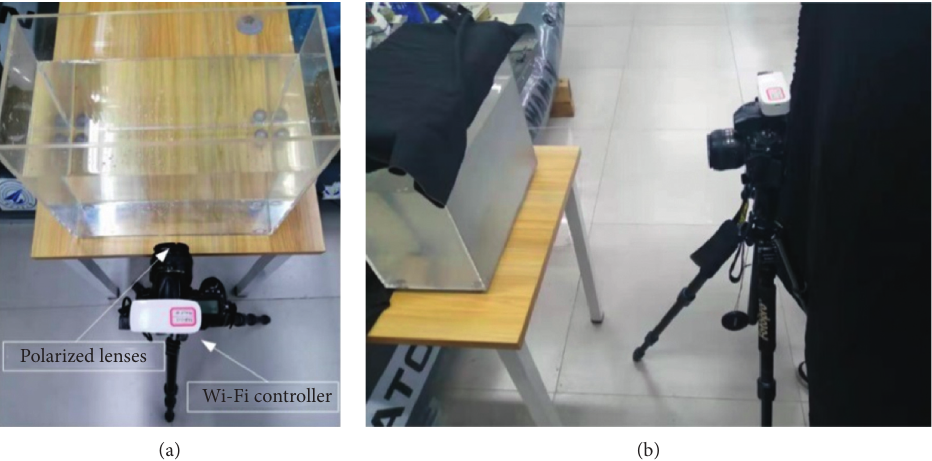
Figure 7: The experimental scenes for collecting the training and test data. The left image (a) and the right image (b) show the scene of shooting the ground truth images in the training phase and test images.